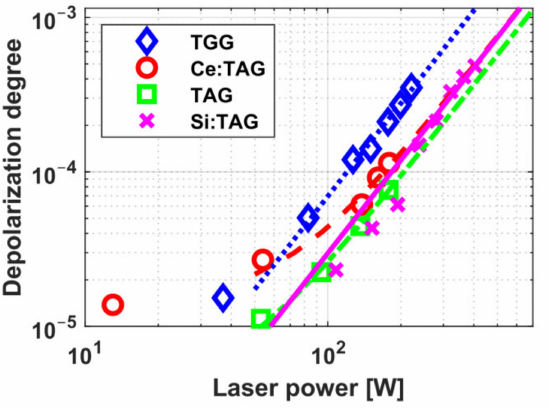
Figure 6. Depolarization degree versus laser radiation power in FI based on TGG, TAG, Si:TAG, and Ce:TAG